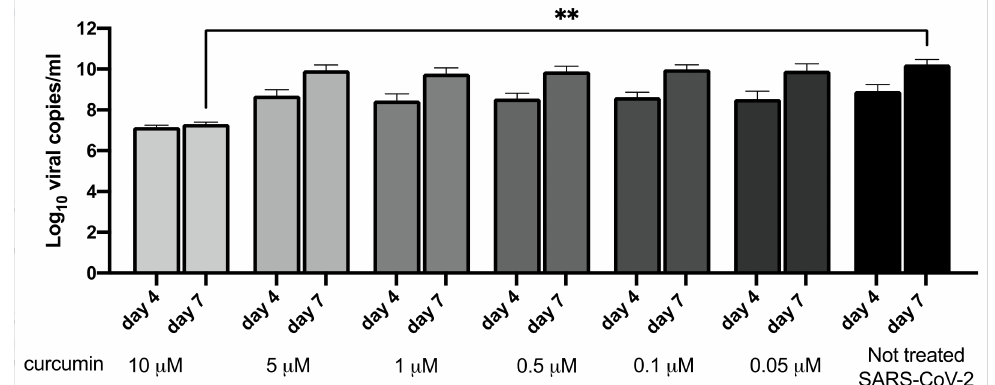
Figure 2. Effect of different concentrations of curcumin (10, 5, 1, 0.5, 0.1, and 0.05 µ M) on SARS- CoV-2 viral load on days 4 and 7 post-treatment/infection. The viral load is expressed as Log 10 viral copies/mL. Result from Kruskal–Wallis tests, adjusted for Dunn’s multiple comparisons test, are displayed. ** p -value < 0.01.